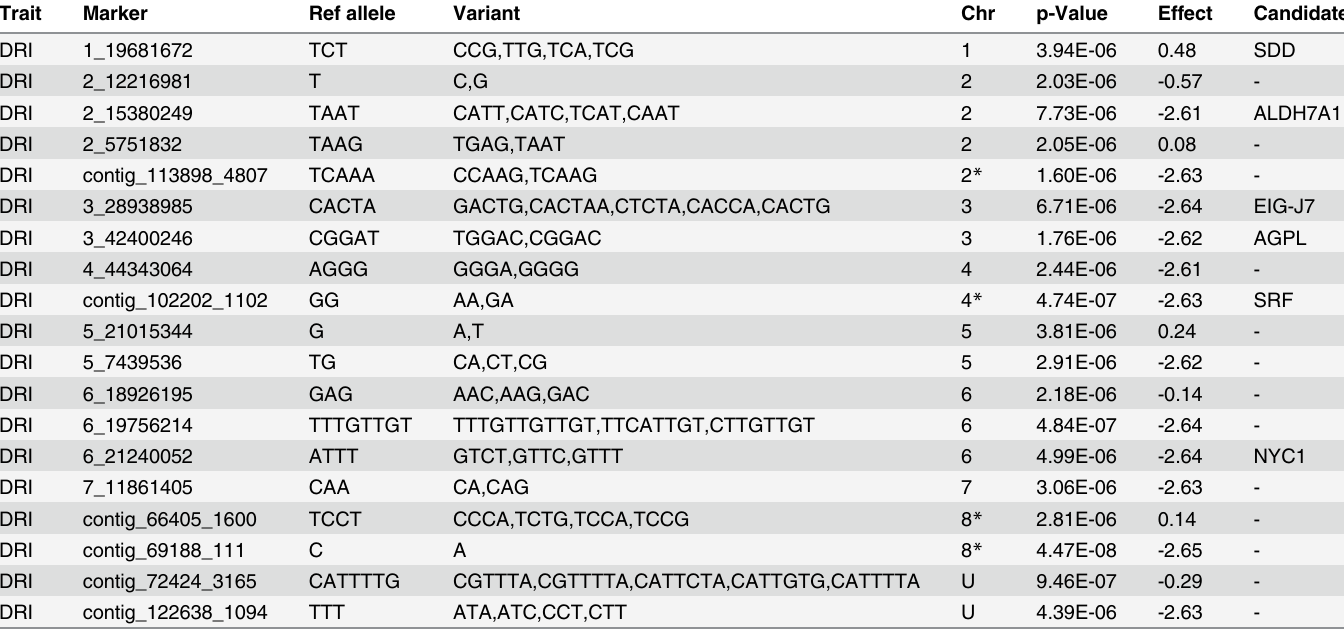
Table 3. Most significant SNP markers associated with drought resistance index (DRI) in alfalfa. Trait Marker Ref allele Variant